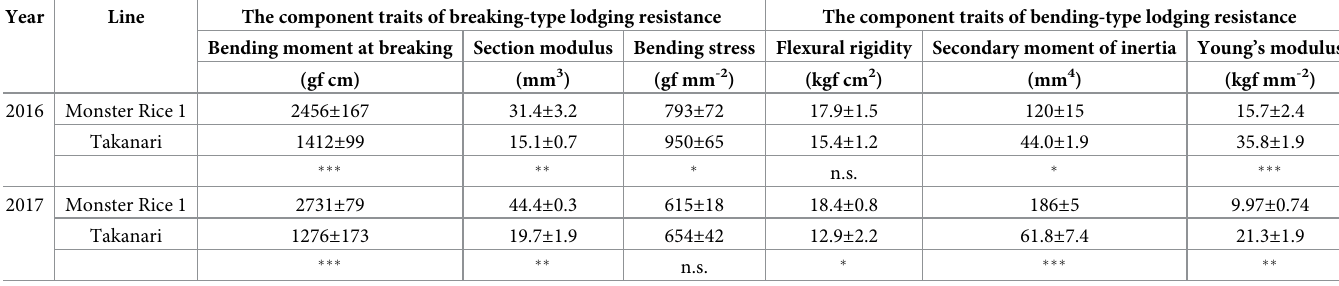
Mean ± SD (n = 3, except for flexural rigidity and Young’s modulus of Monster Rice 1 in 2017, n = 2). Asterisks indicate significant difference between cultivars: n.s. indicates no difference, � , �� and ��� indicate P < 0.05, 0.01, 0.001, respectively